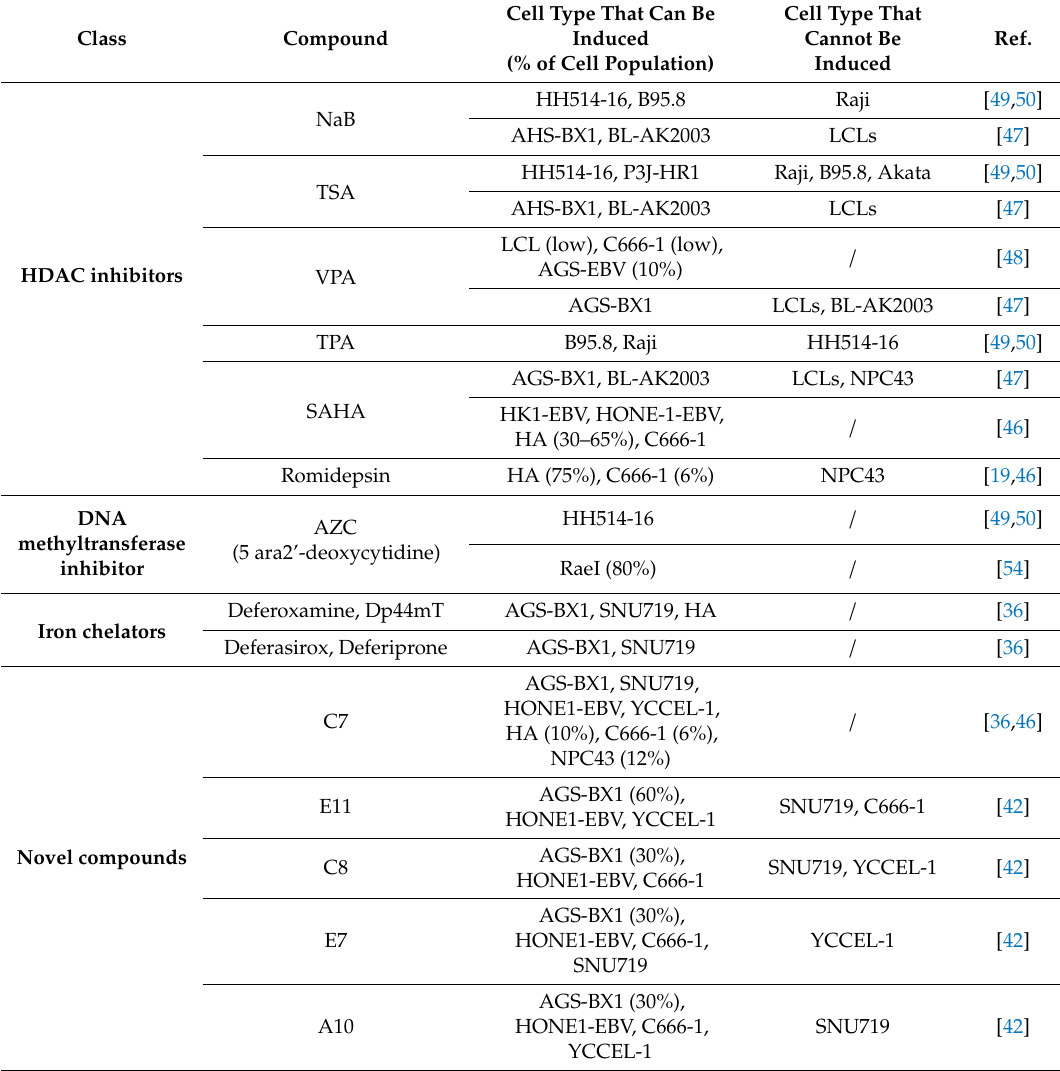
Table 1. Summary of the e ffi ciency of lytic induction of Epstein–Barr virus (EBV) of the lytic inducers and the cell types in which lytic cycle can be induced